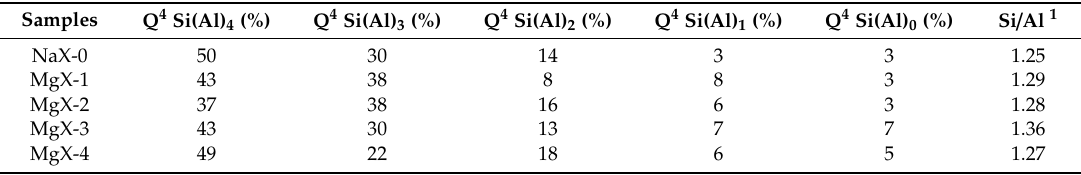
Table 3. Relative peak area (%) and Si / Al ratio determined from the 29 Si MAS NMR spectra of the raw and magnesium forms of FAU-type zeolites.